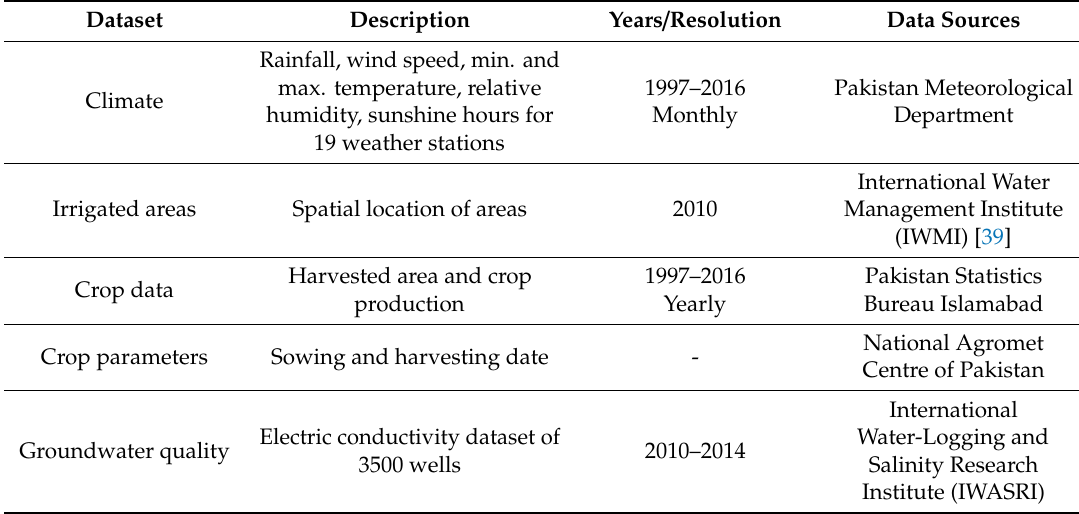
Table 1. Spatial model input data used in this